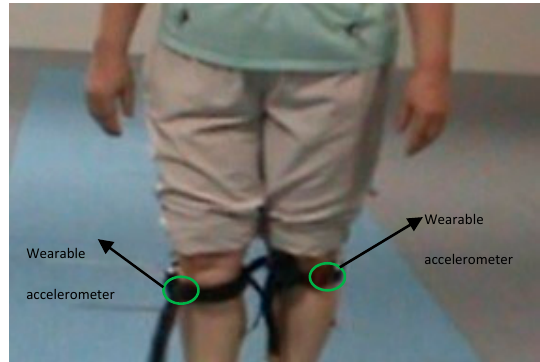
Figure 1. The position of the wearable accelerometer for the clinical experiment.